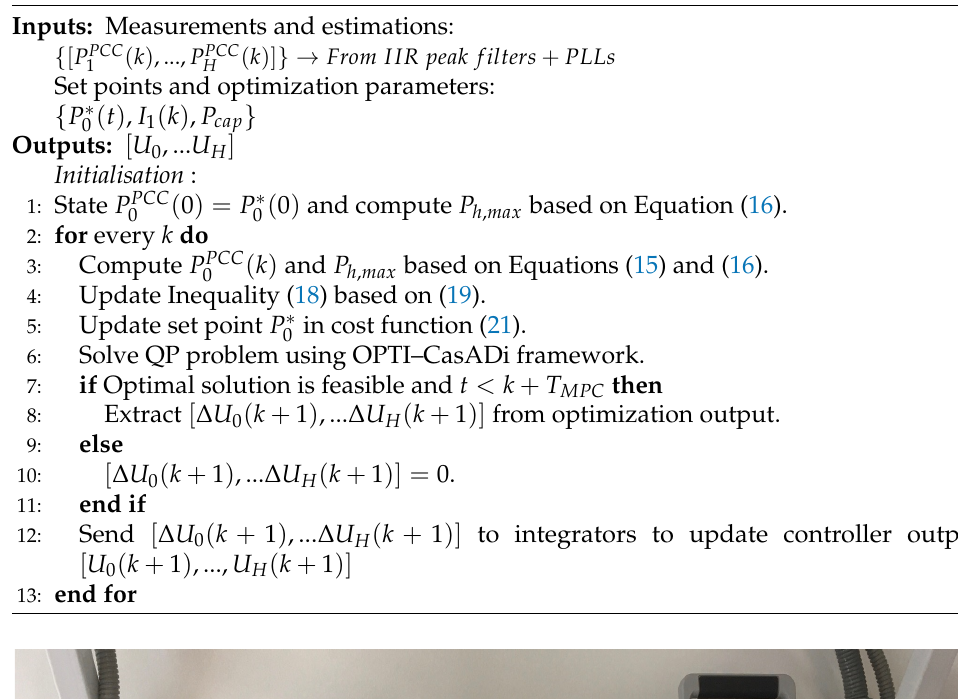
Algorithm 1 DMPC solution for harmonics compensation